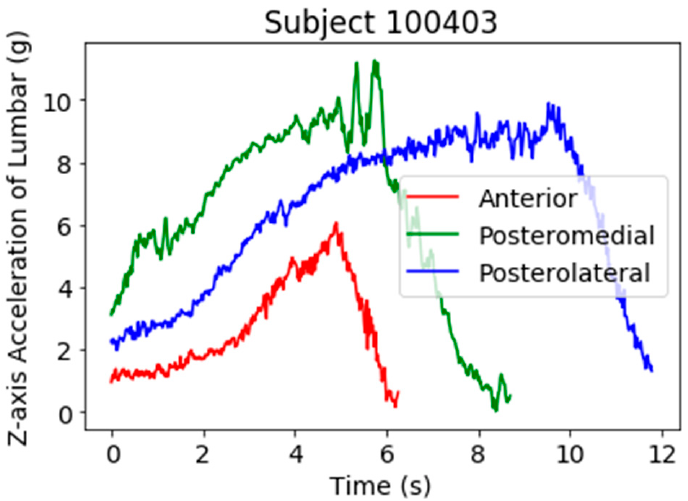
Figure 2. Z -axis lumbar acceleration signal of YBT excursions from subject 100403. These excursions have different lengths: from 113 to 648 data-points (2.2 s to 12.7 s), with a mean of 324.83 data-points (6.3 s) and a standard deviation of 115.84 data-points (2.3 s). Figure 3 shows the histograms of YBT excursions of the dataset depending on dura- tion. The specific histograms for each direction show that YBT excursions of the anterior direction usually last less time than posteromedial and posterolateral excursions.